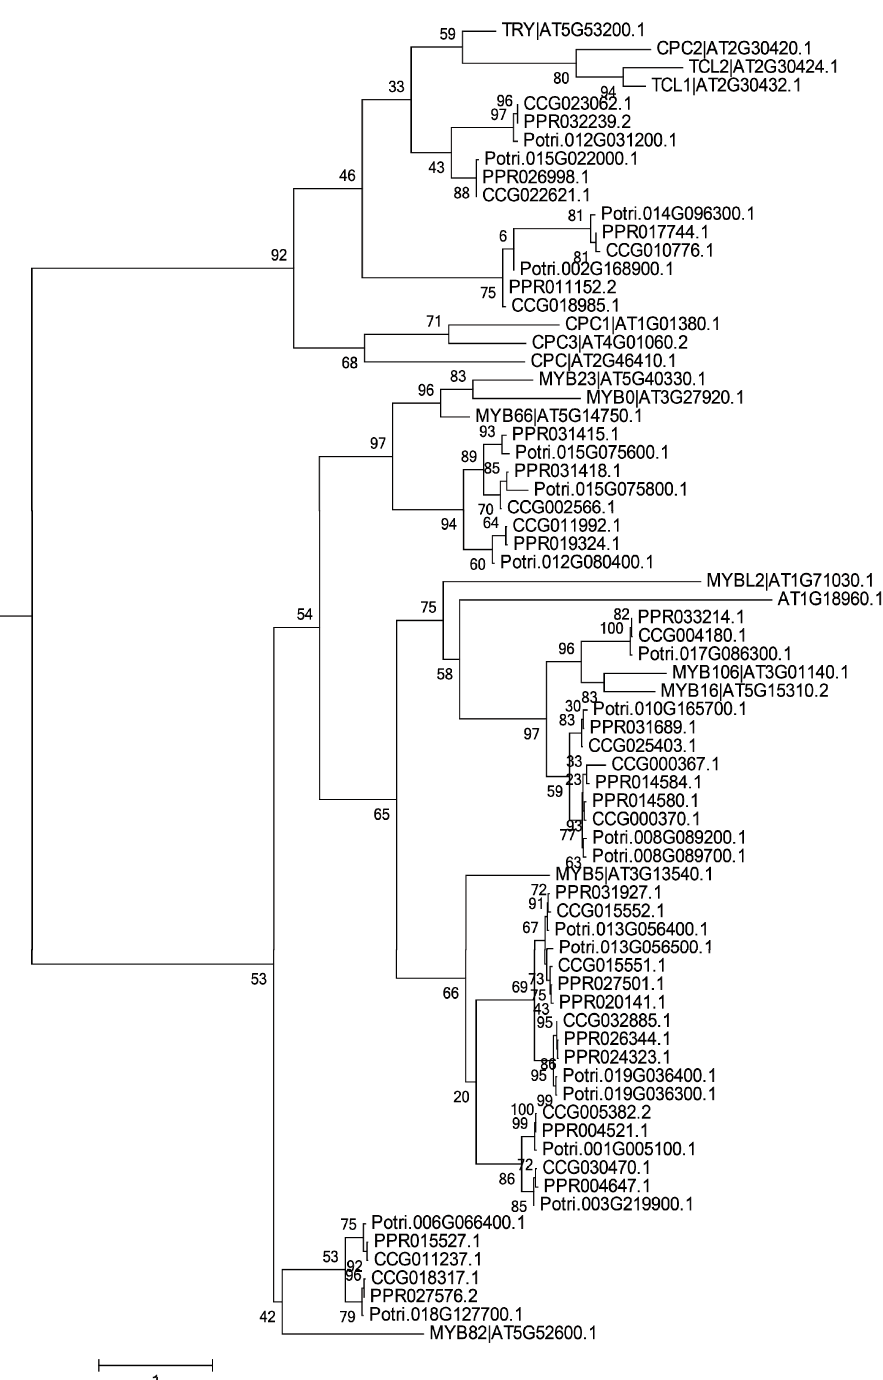
Figure 4. Phylogenetic relationships of MYB TFs from Arabidopsis , P. trichocarpa , P. pruinosa , and P. euphratica . The phylogenetic tree was built using the maximum likelihood method implemented in RAxML. Homology of genes between Arabidopsis and the three poplars was confirmed using the tree.